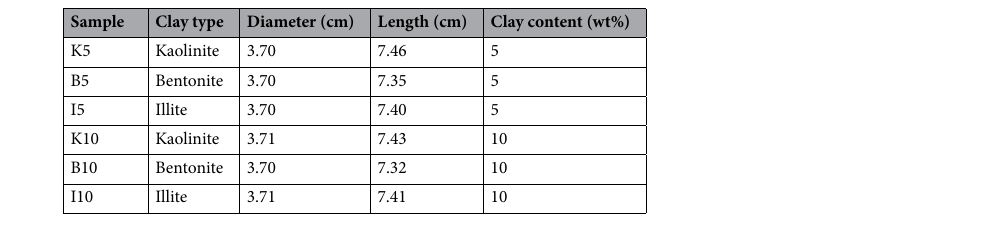
Table 3. Dimensions and clay content of samples.